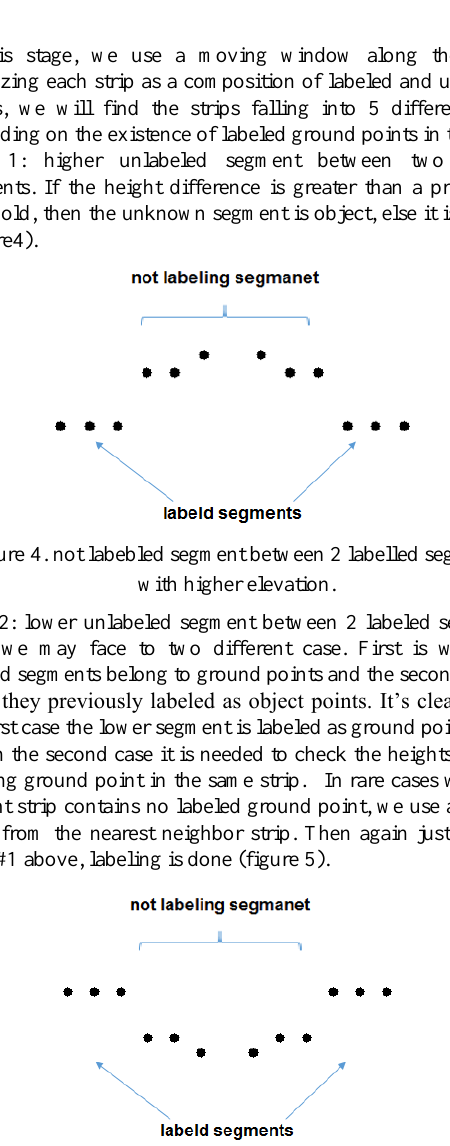
Figure 5. not labelled segment between 2 labelled segments with lower elevation.